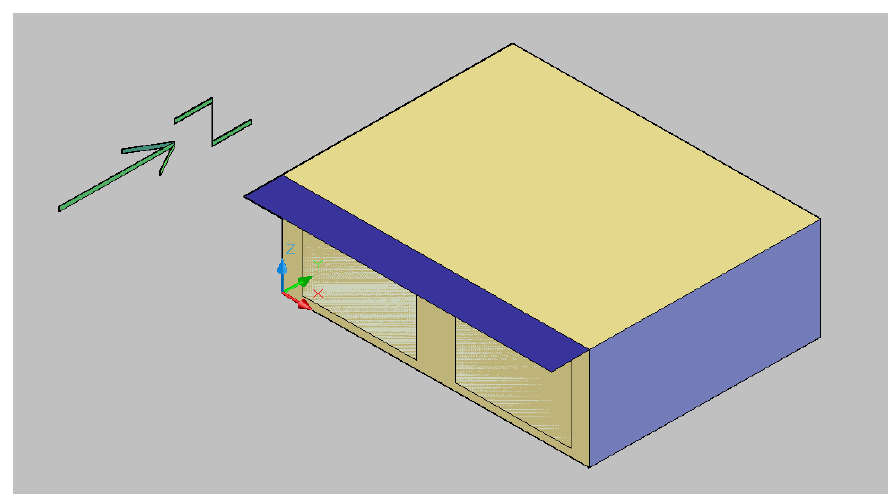
Figure 1. Model of the building used for simulation calculations.